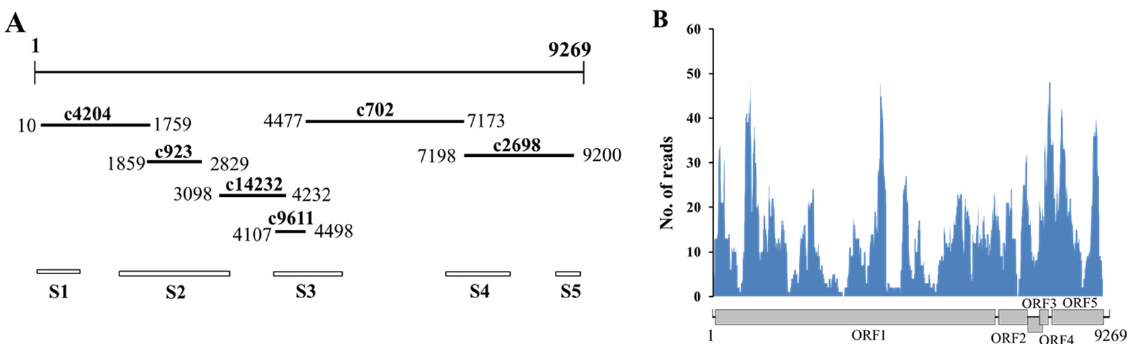
Figure 1. RNA-Seq derived contigs ( A ) and profile distribution of RNA reads ( B ) along genomic RNA of ASPV isolate DL. ( A ) Black bold lines represent contigs and their positions at the genome of ASPV-DL were indicated. Rectangles indicate the five segments (S) amplified by nRT-PCR. ( B ) A schematic diagram of the genome organization of ASPV isolate DL was used as reference.